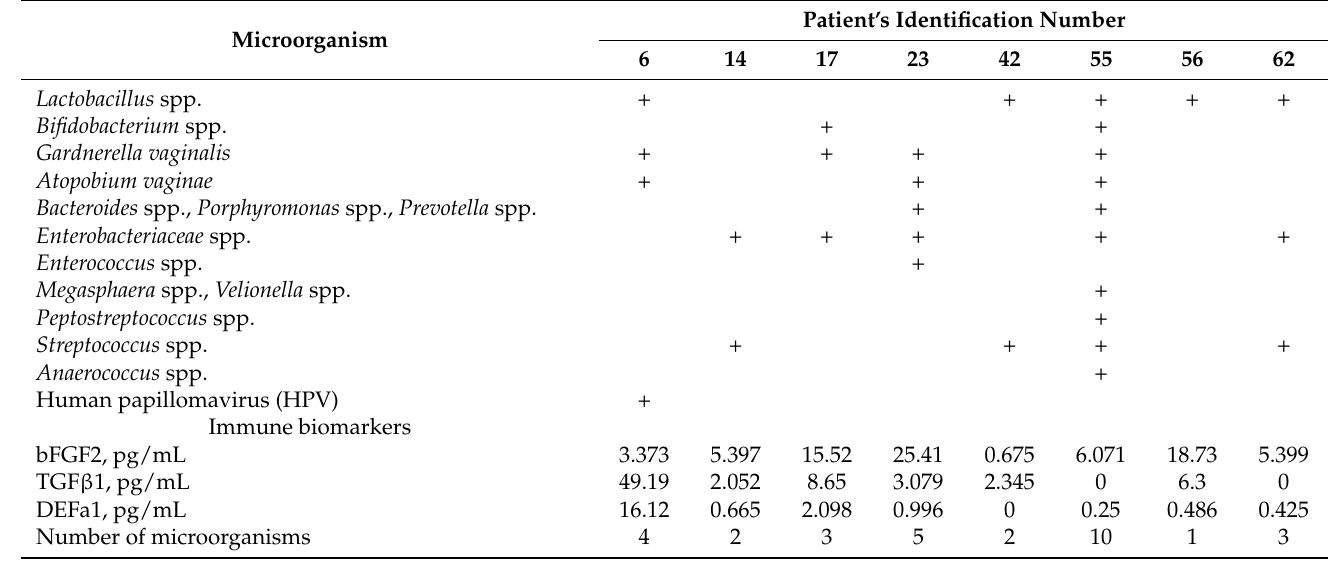
Table 4. Composition of endometrial microbiota and biomarker concentrations in patients with pregnancy achieved during the follow-up